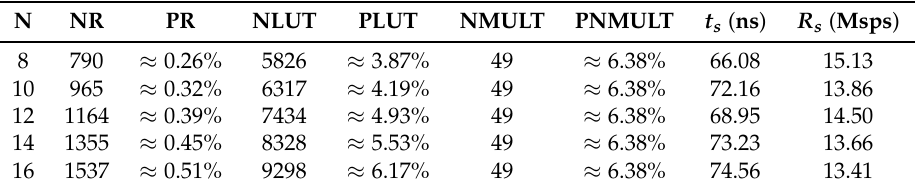
Table 4. Synthesis results (hardware requirement and time) associated with Fuzzy-PI controller hardware with TS-FIMM-P.